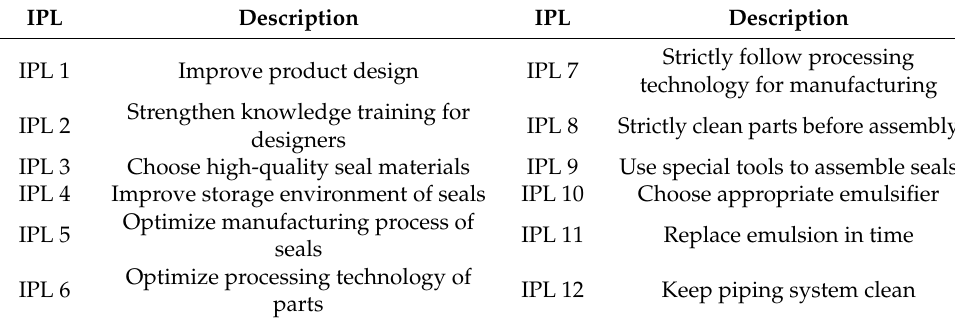
Table 6. Countermeasures to prevent the jack from